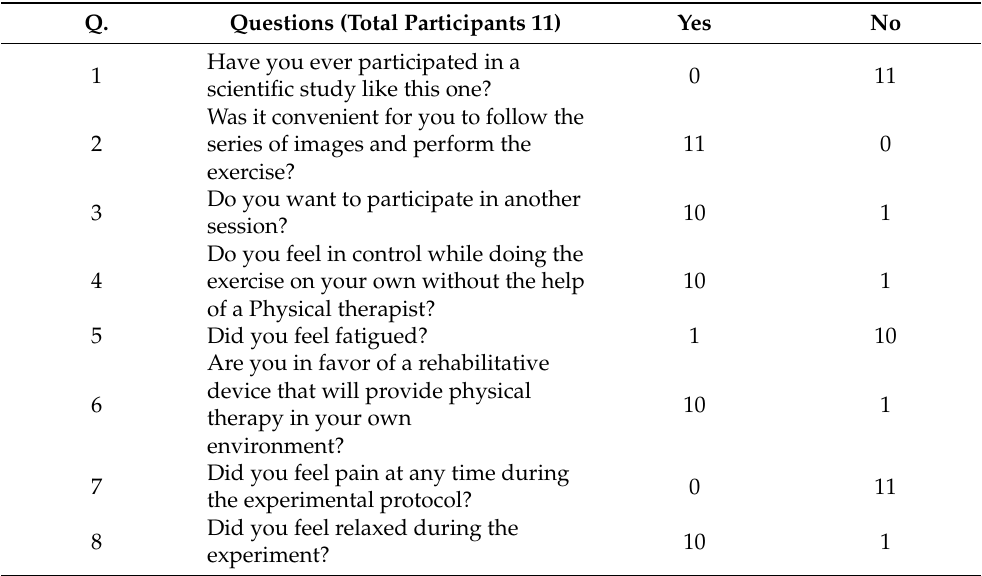
Table 3. Set of questions that were posed to each subject at the end of recording session and each subject’s